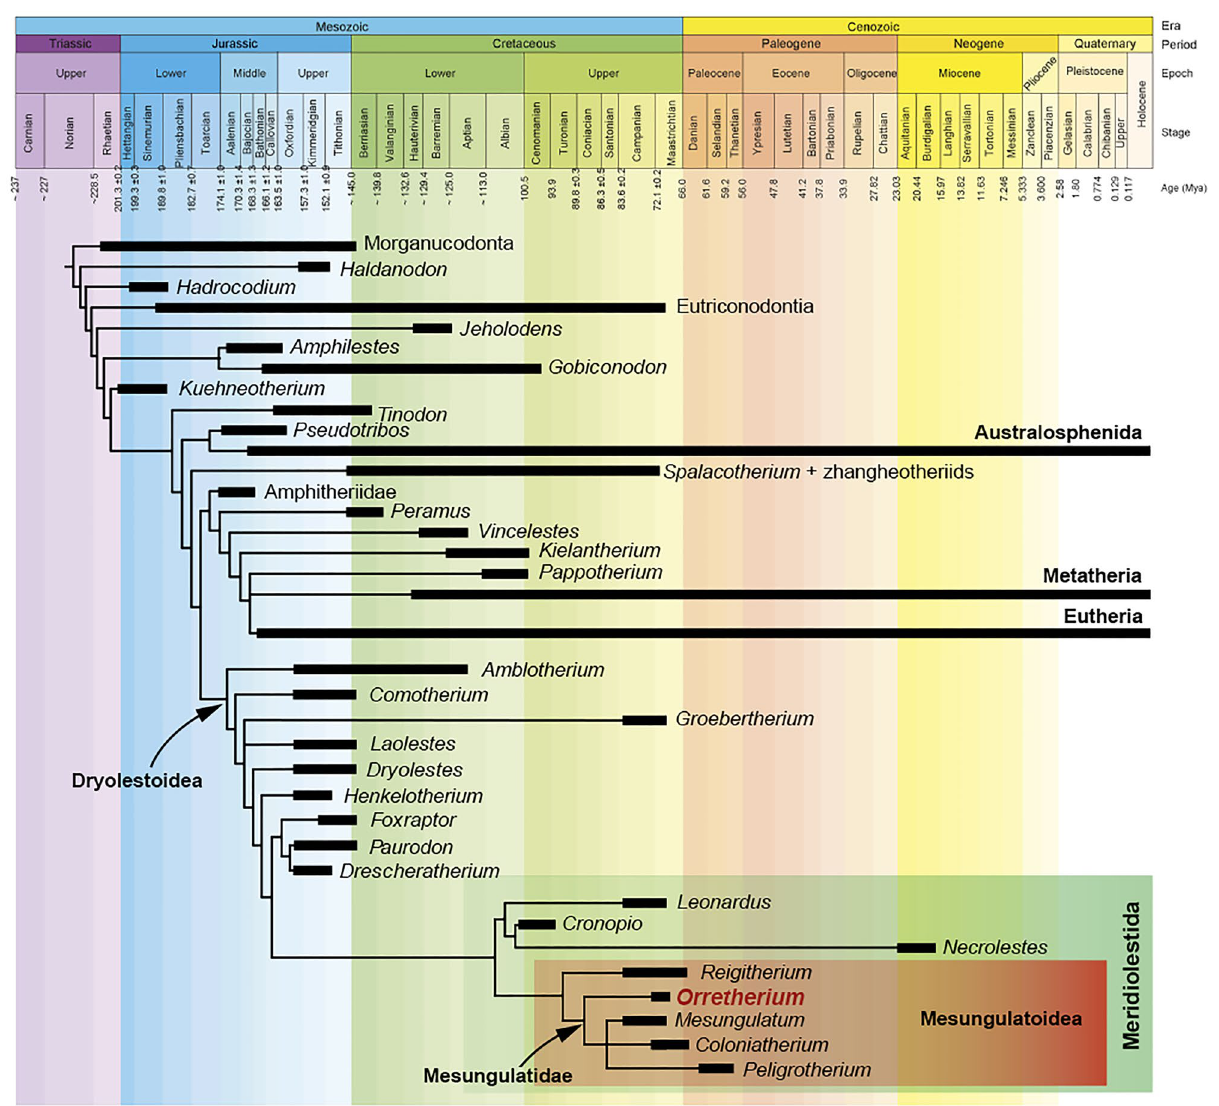
Figure 7. Time-calibrated phylogenetic trees. Simplified strict consensus tree of 12 MPTs with the position of Orretherium tzen among meridiolestidan